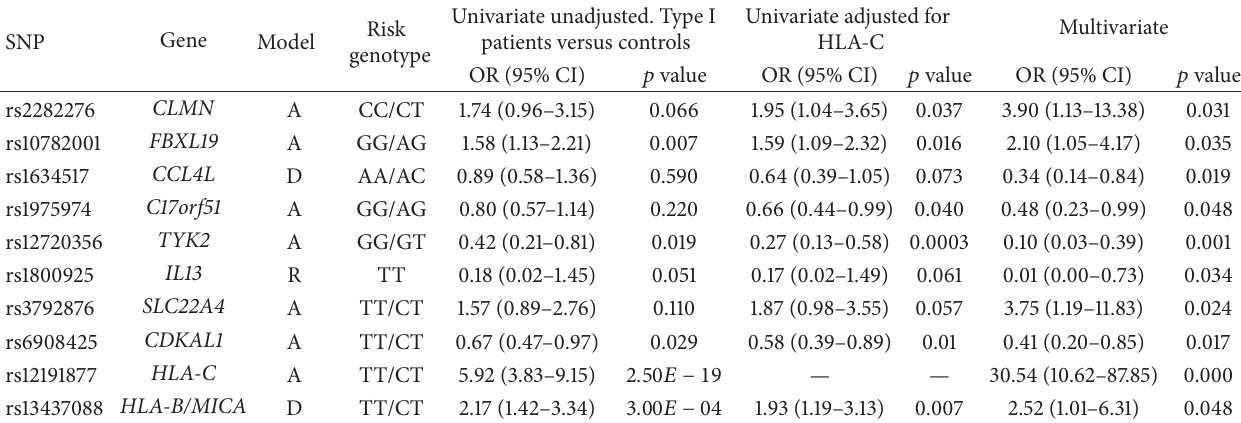
Table 2: Results of univariate linear regression analysis (unadjusted and adjusted for rs12191877 in HLA-C ) and multivariate linear regression analysis(155 patientswithtypeIpsoriasisversus197controls). Inthemultivariateanalysis,weincluded theSNPs with 𝑝 < 0.1 intheunivariate analysis adjusted for HLA-C . Only polymorphisms that were significant in the multivariate analysis are